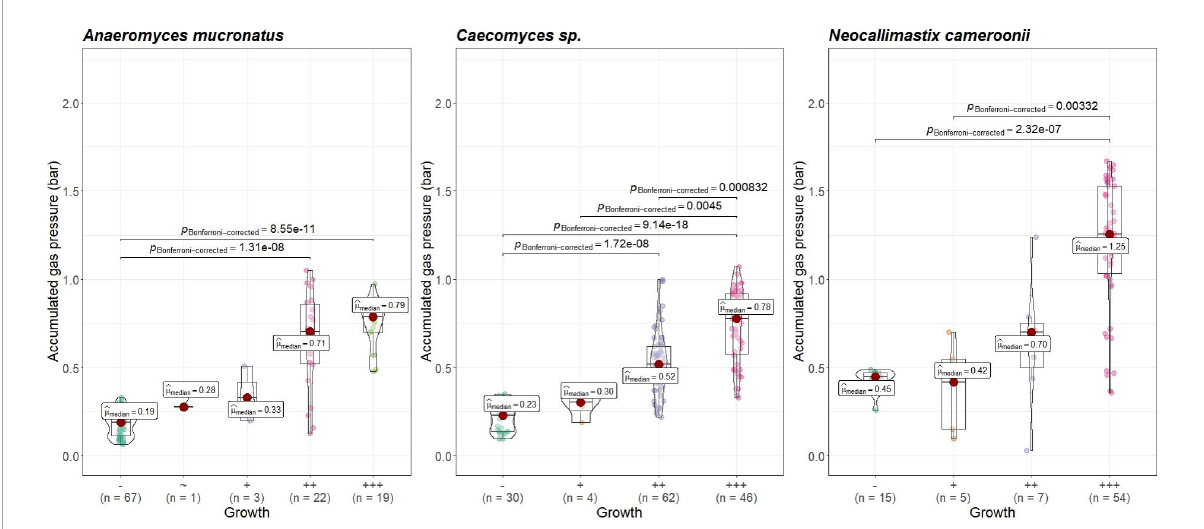
FIGURE7 Correlation between AF visual growth inspection and accumulated gas pressure at lab A. Visual growth evaluation categories: “–”, no growth; “+++”, very good growth. Statistical tests: Kruskal–Wallis with post hoc Dunn-test. Only significant pairwise comparisons are shown.